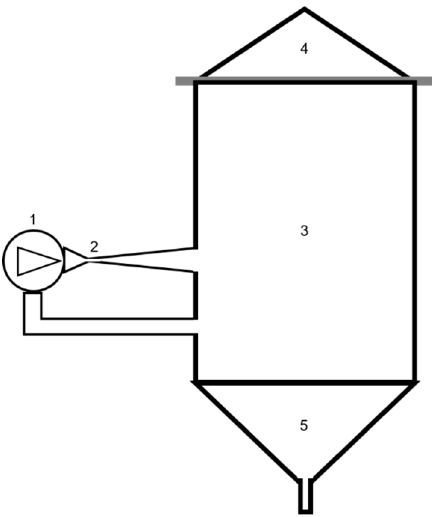
Figure 1. Experimental hydrodynamic cavitation (HC)-based installation. (1) Centrifugal pump, (2) HC reactor, (3) main vessel, (4) cover, (5) discharge.